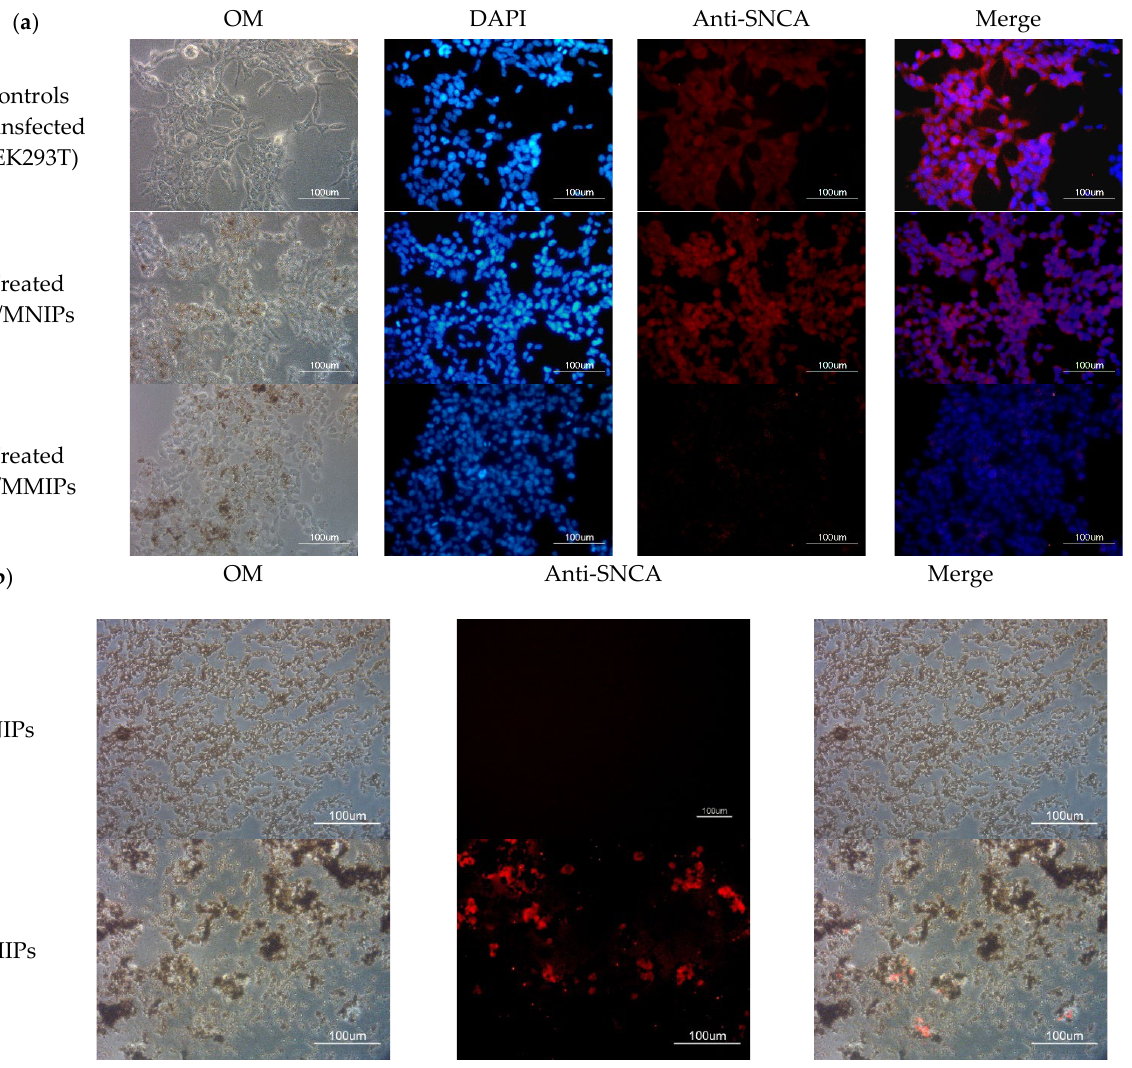
Figure 6. ( a ) Optical, nuclear (DAPI) staining, and immunostaining images of anti-SNCA proteins and merge images of HEK293T cells treated with MNIPs or MMIPs. ( b ) Optical and immunostaining images of anti-SNCA protein and merge images of MNIPs or